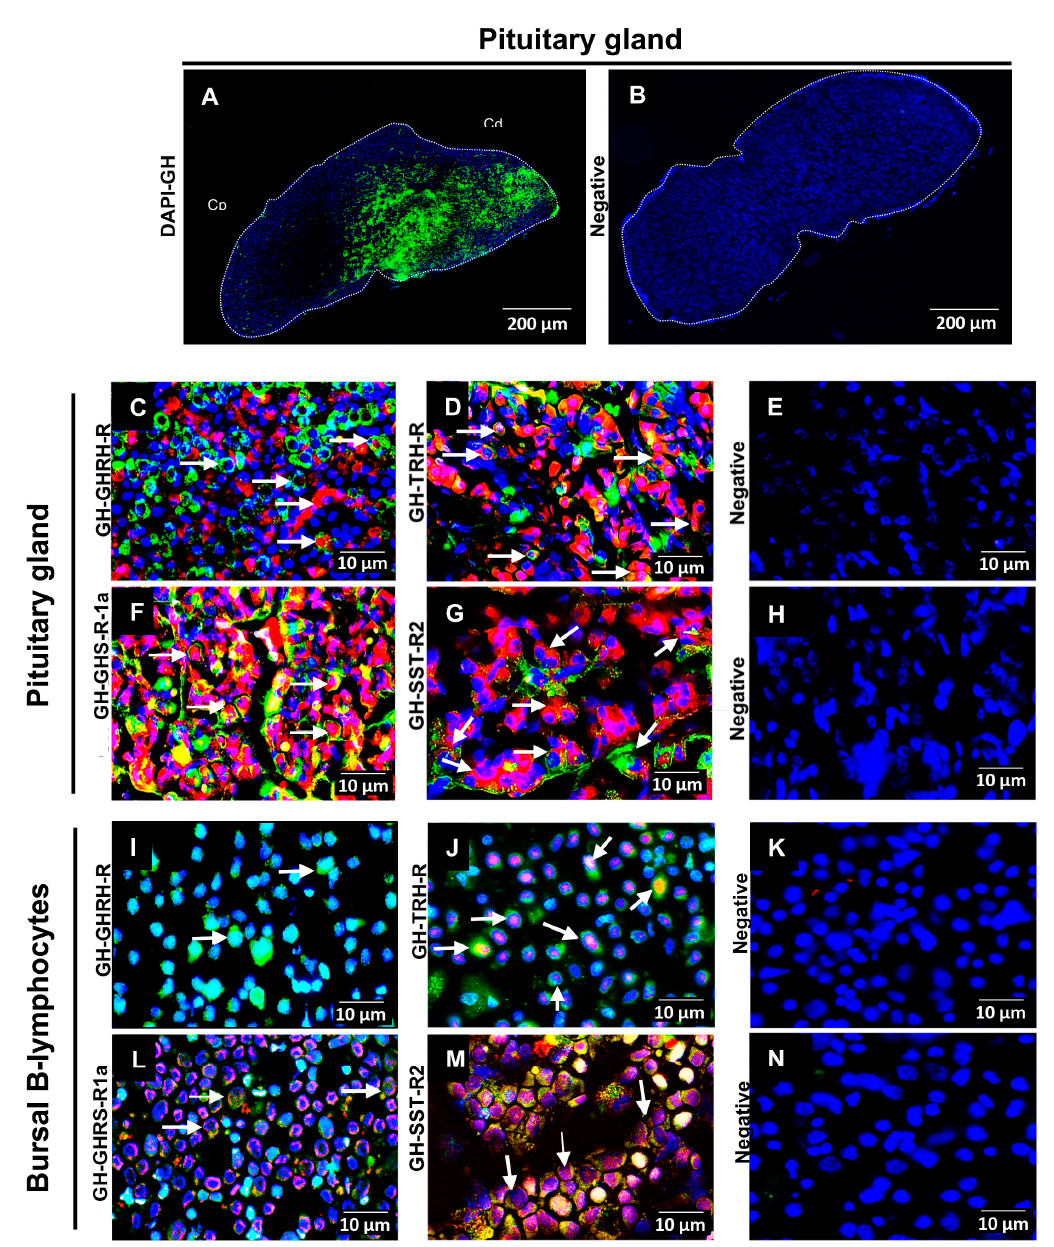
Figure 3. Co-localization of growth hormone (GH) and several secretagogue receptors in pituitary and BBL cultures. ( A ) As a positive control, sagittal slices of a four-week old chicken pituitary were used. Most GH-immunoreactivity (GH-IR) was located in the somatotroph cells of the caudal lobe (Cd) (green), and scarcely in the cephalic lobe (Cp). Negative controls were obtained using only Alexa 594 and Alexa 488 for both, pituitary gland and isolated BBLs ( B , E , H , K , N ). The localization of GH immunoreactivity was observed in green. On the other hand, distribution of GHRH-R, TRH-R, GHS-R1a, and SST-R 2 immunoreactivities were observed in red; in pituitary ( C , D , F , G ) and BBLs ( I , J , L , M ). Nuclei were visualized with DAPI (blue). Arrows show immunoreactive cells to one or co-localization of both antibodies. Representative micrographs of n = 3 independent